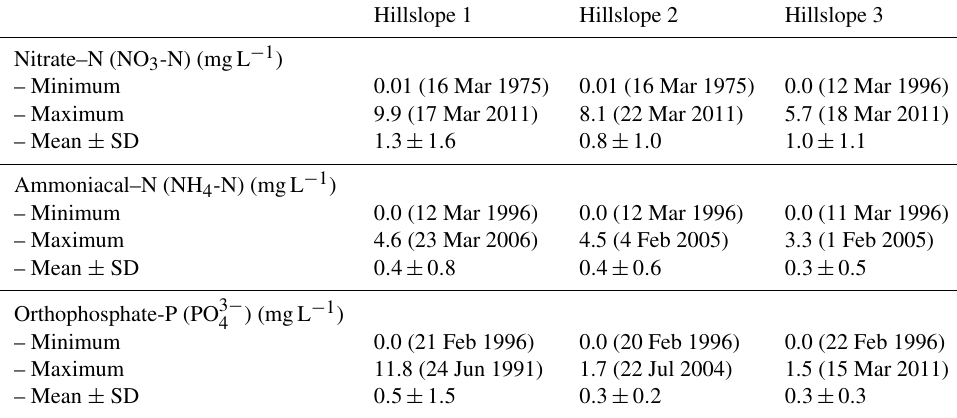
Table 4. Summary statistics of runoff nutrient concentration